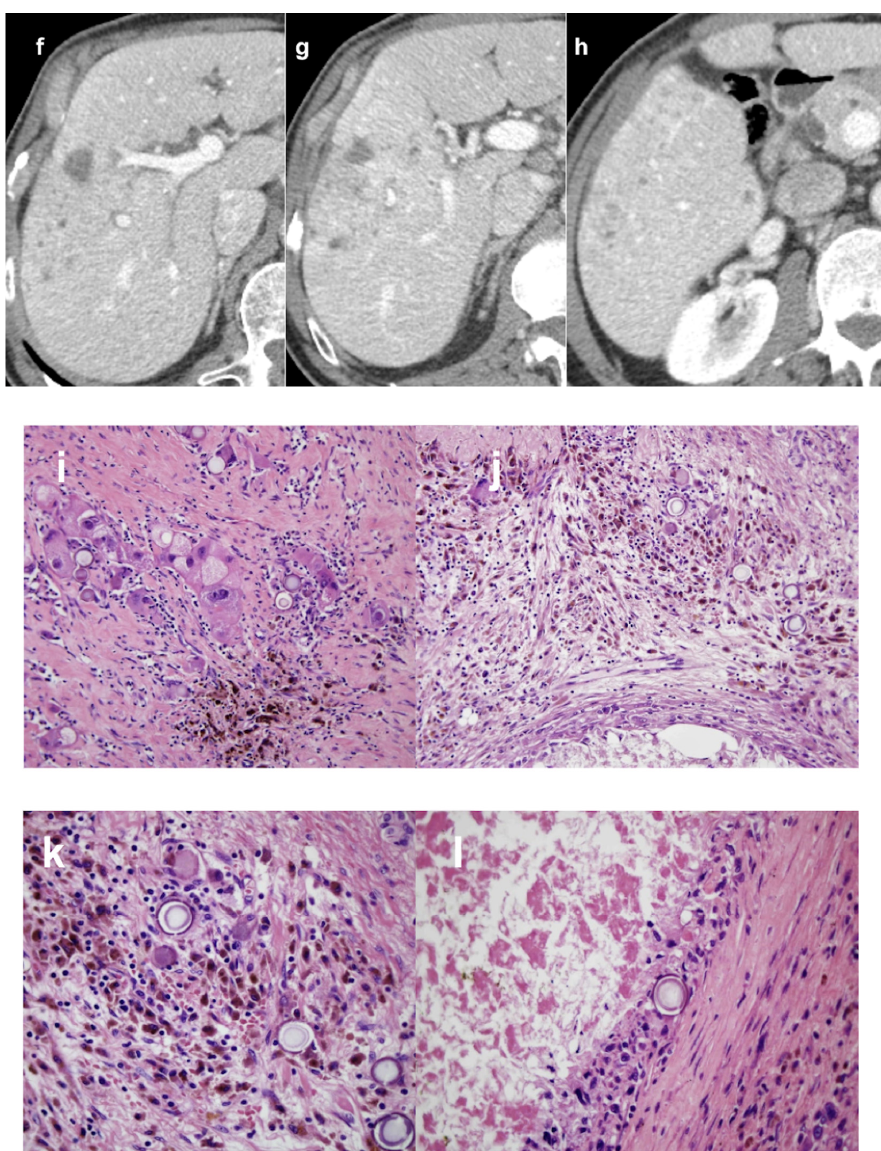
Figure 2. Downstaging of HCC with 116 Holmium TARE. Infiltrative biopsy proven HCC in right liver lobe at CT before treatment ( a – c , different levels) in portal-venous phase; AFP was 493 μ g/L. 116 Holmium TARE was performed with a downstaging intent ( d : angiogram from the right hepatic artery; e : PET-CT after treatment); the administered activity was 3.6 GBq. At 45 days CT follow-up ( f – h , same levels as a – c ), lesion progressive devascularization and decrease in size were depicted; AFP was 251 µ g/L. Liver transplantation was performed 81 days after 116 Holmium TARE. At pathologic examination of the explanted liver ( i – l ), ≈ 50% necrosis was found with viable tumor mainly at the periphery of the lesion and fibroblastic reaction associated with inflammatory response rich in pigmented macrophages. 116 Holmium microspheres are visible in histology ( I , j : magnification 20 × ; k , l : magnification 40 ×